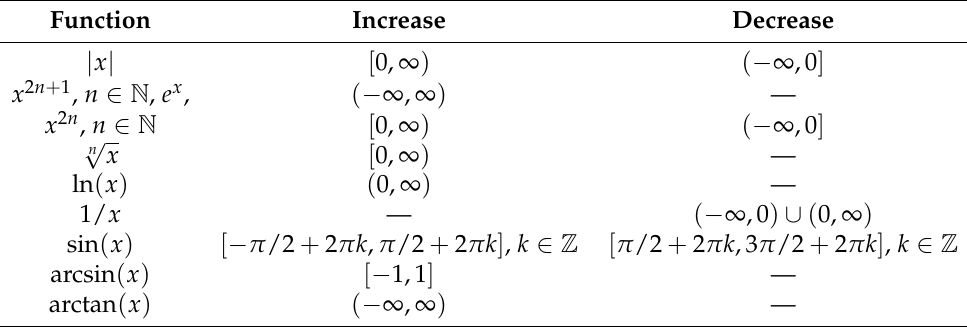
Table 2. The monotonicity of elementary